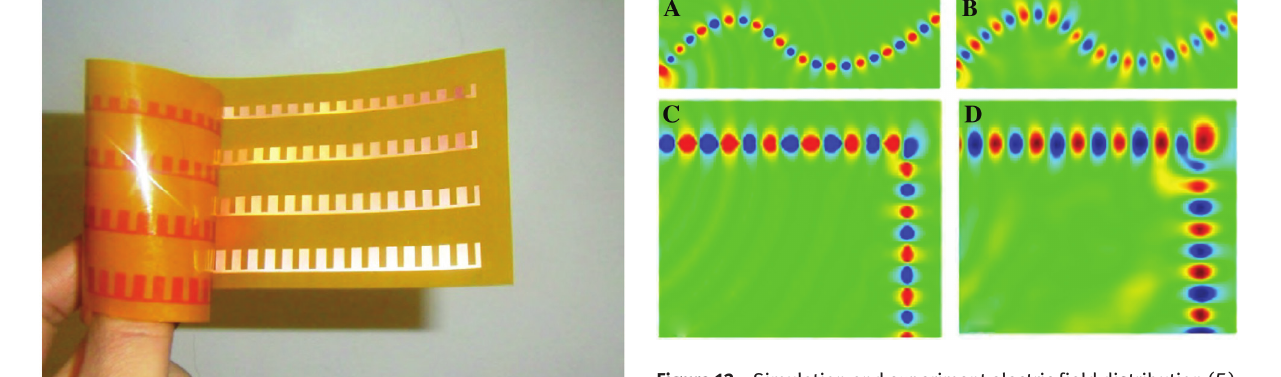
Figure 12: Simulation and experiment electric field distribution ( E at 10 GHz. (A) and (B) illustrate the simulation and measurement results for the S-bending surface, respectively. (C) and (D) represent the simulated and measured results for cubical surface, in which CSPs creep through the sharp corner